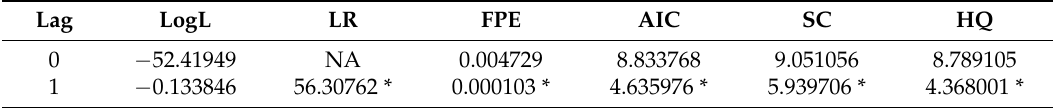
Table 13. Lag selection criteria for petroleum and natural gas extraction.